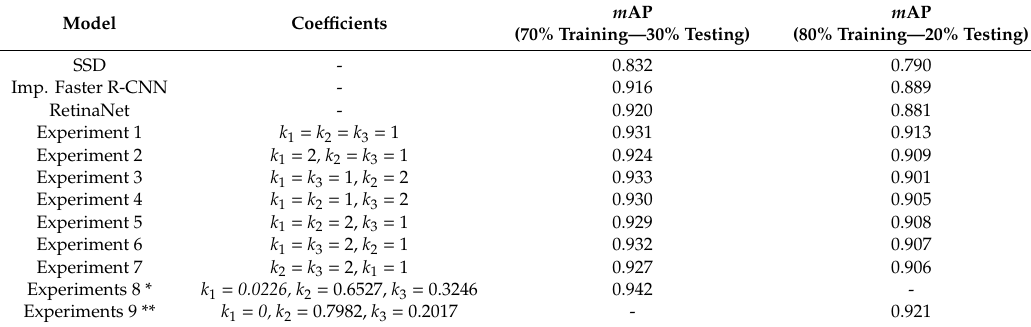
Comparison of the results of three di ff erent object detection models and di ff erent coe ffi cient combinations for the Northwestern Polytechnical University Very High Resolution 10 (NWPU-VHR10)